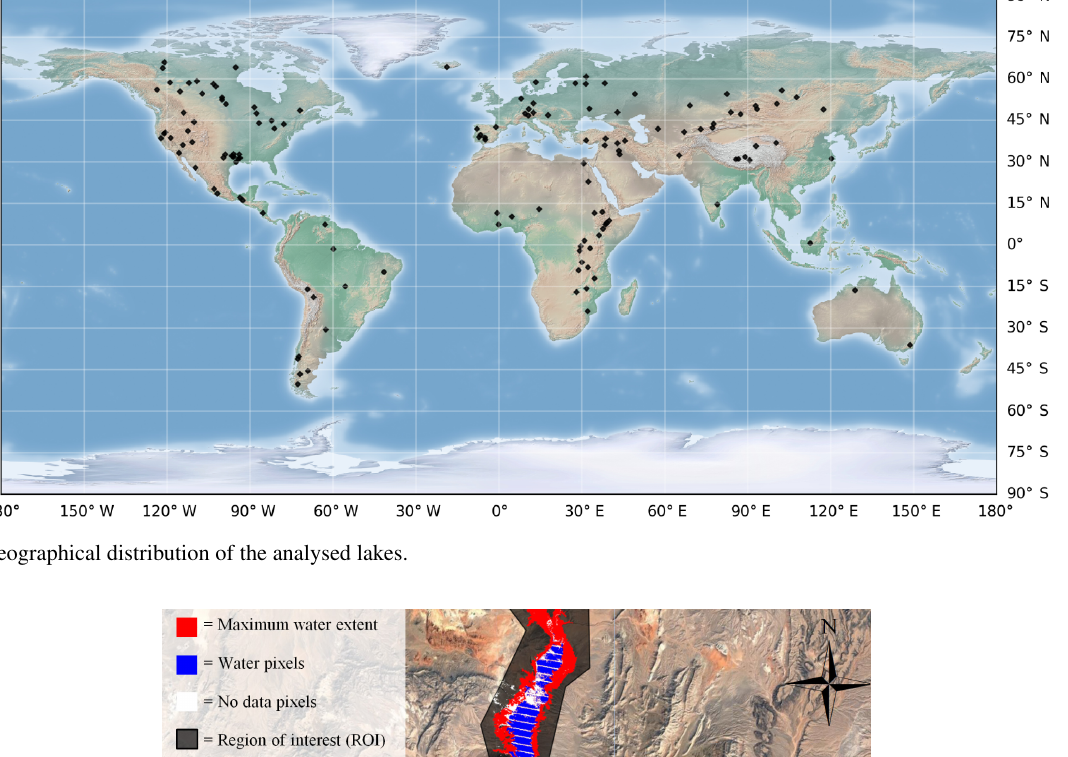
Figure 1. Geographical distribution of the analysed lakes.